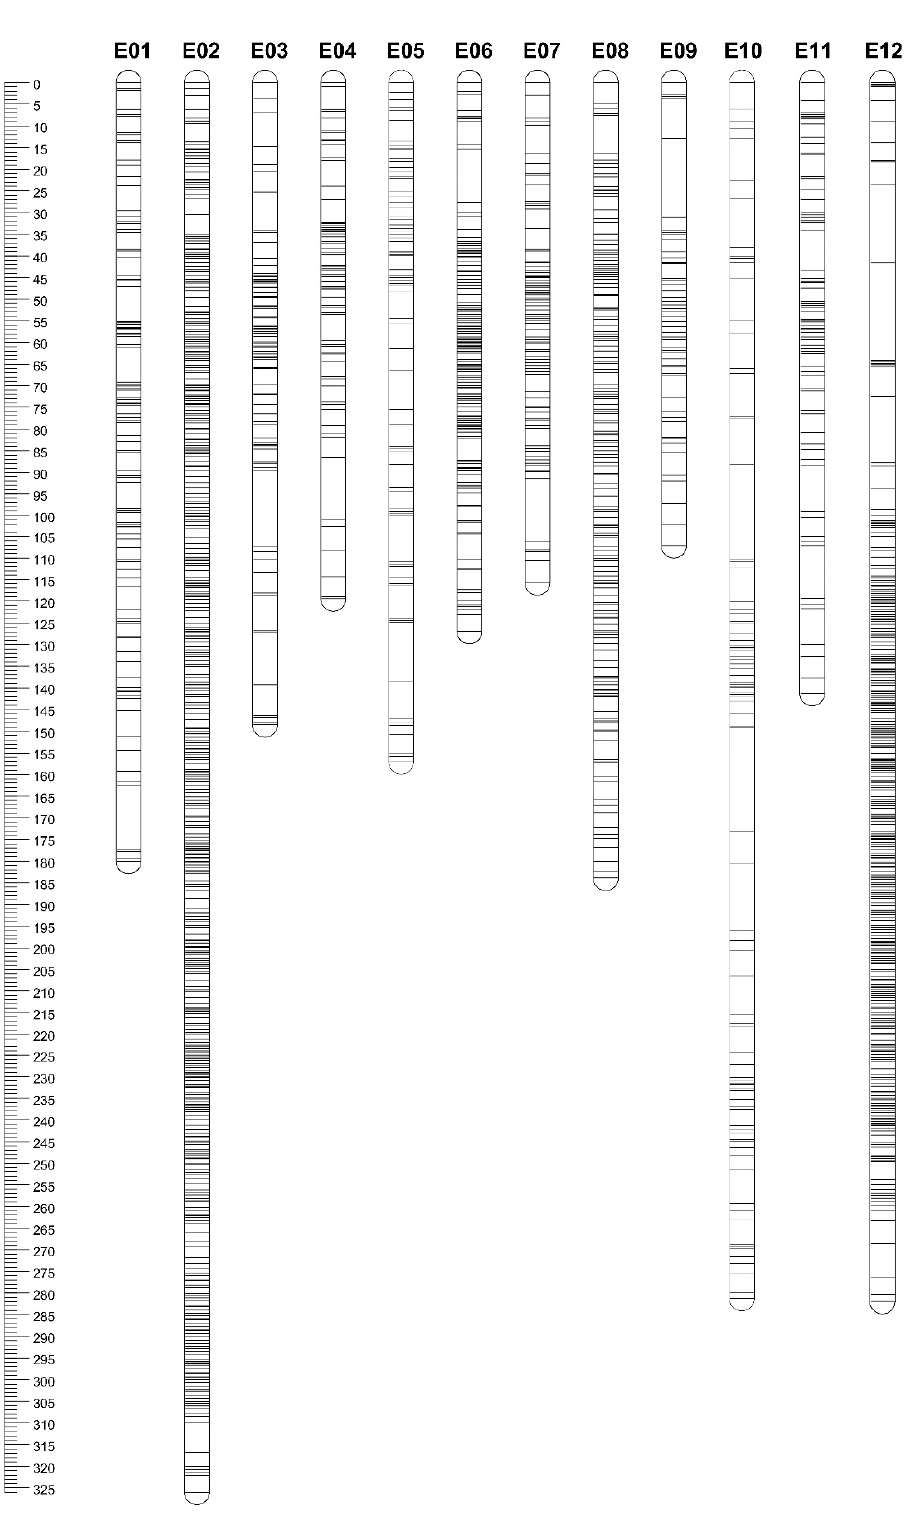
Figure 2. Eggplant linkage map depicting the size of the chromosomes and markers distribution. Marker names and map distances (in cM) are detailed in Figure S2.